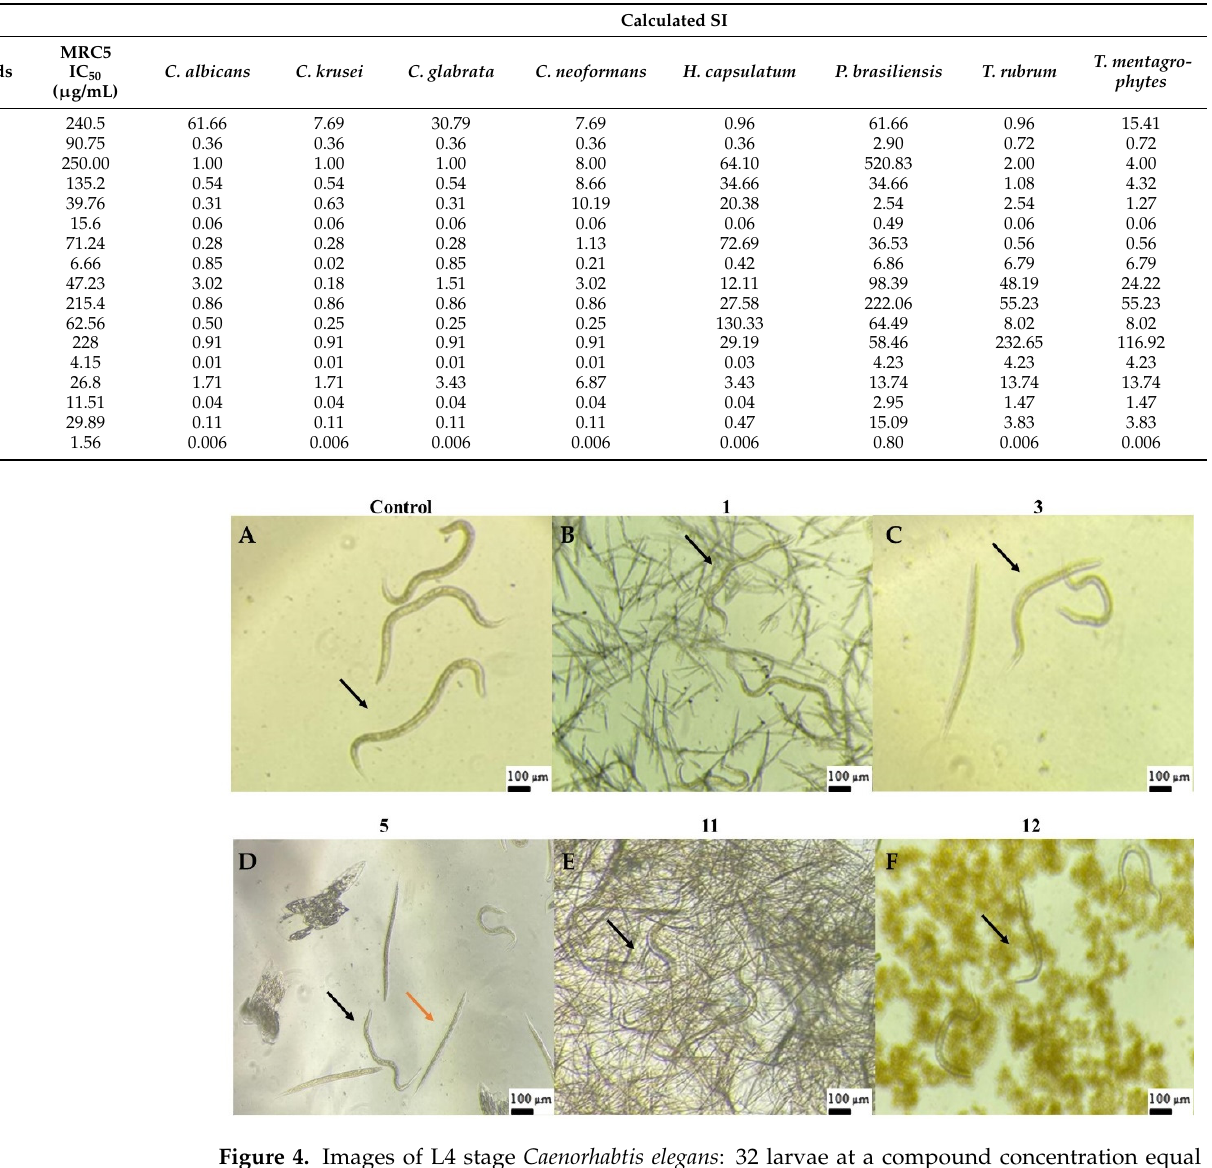
Table 5. Selectivity index (MIC 90 /IC 50 ) of nitrofuran derivatives against different fungi species compared to the MRC-5 lung cells.